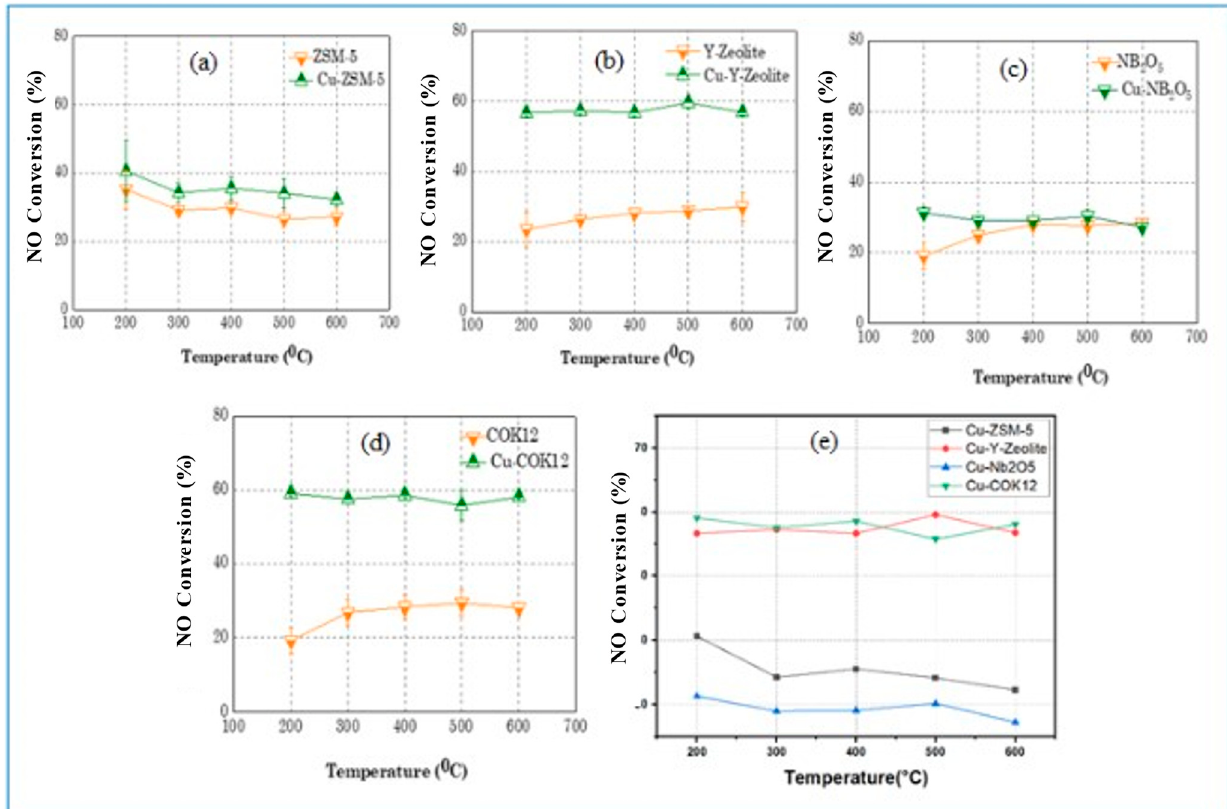
Figure 12. NO conversion rate (%) vs. Temperature (°C) for ( a ) ZSM5 & Cu-ZSM5, ( b ) Y-Zeolite & Cu-Y-Zeolite, ( c ) Nb 2 O 5 and Cu- Nb 2 O 5, ( d ) COK12 and Cu-COK12, and ( e ) Comparative plot for Cu over COK12, Nb 2 O 5, Y-Zeolite, and ZSM5.